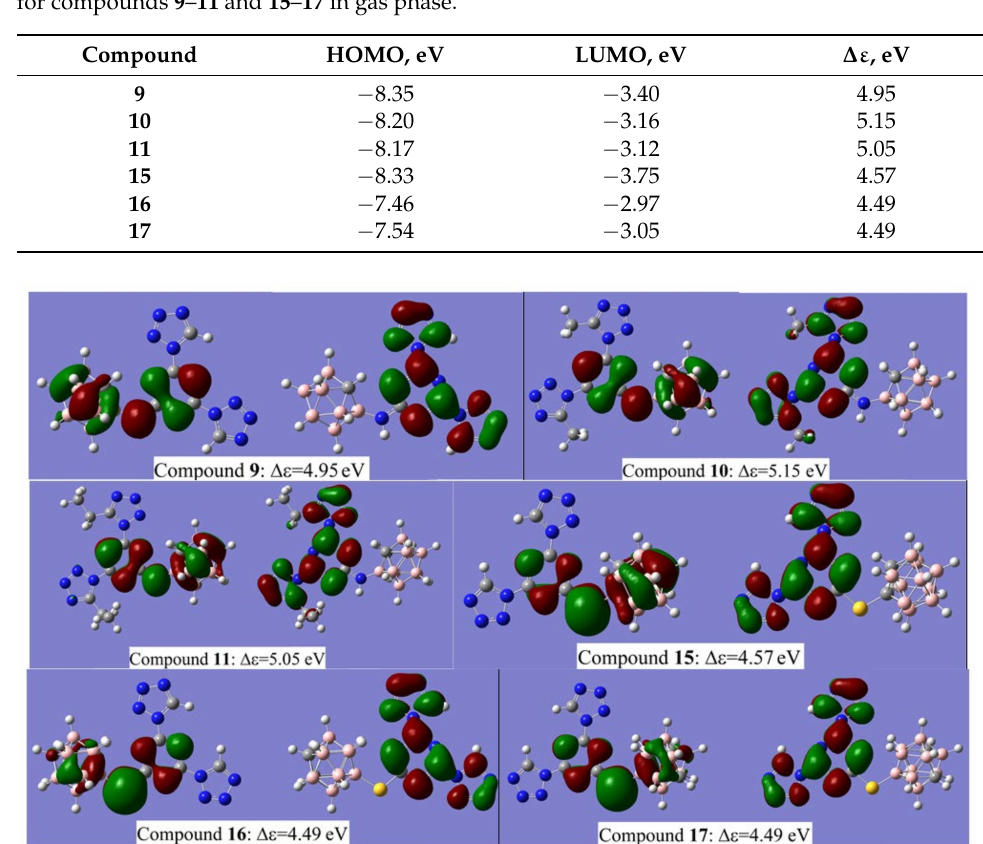
Figure 10. Plots of HOMO (left) and LUMO (right) iso -surfaces for compounds 9 – 11 and 15 – 17